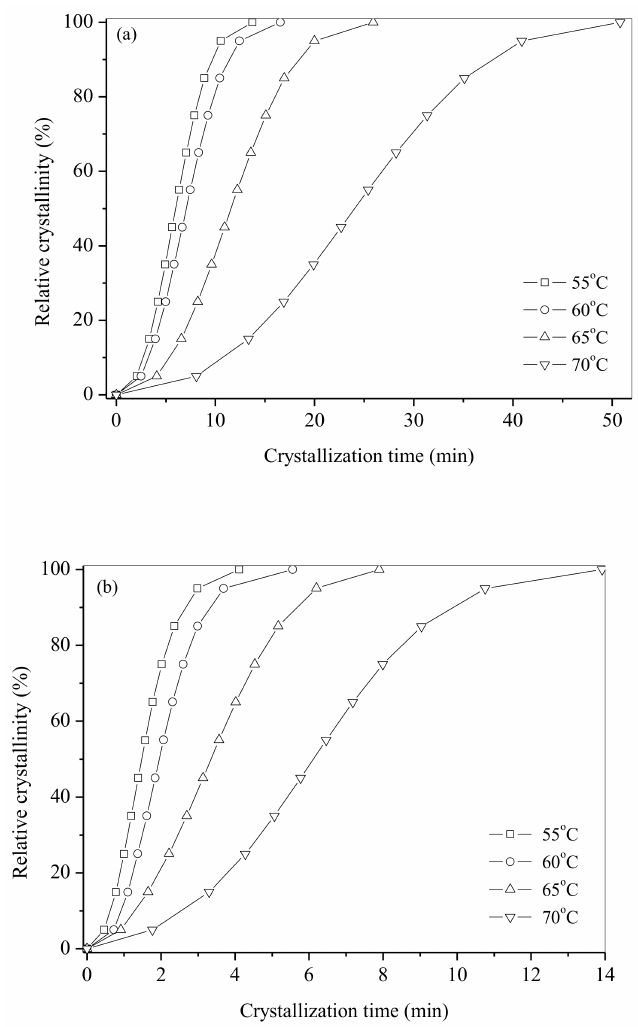
Figure 3. Plots of relative crystallinity versus crystallization time for ( a ) neat b-PES and ( b ) b-